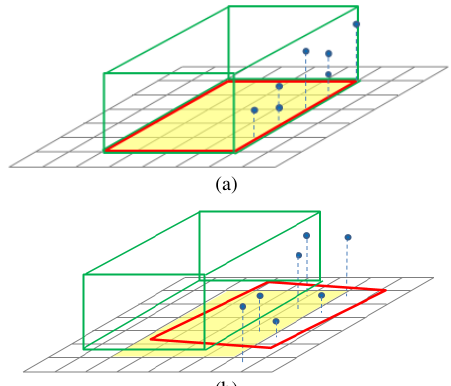
Figure 3. Multiple representations of a building in an ideal consistent and error-free world (a), and in the real world (b).